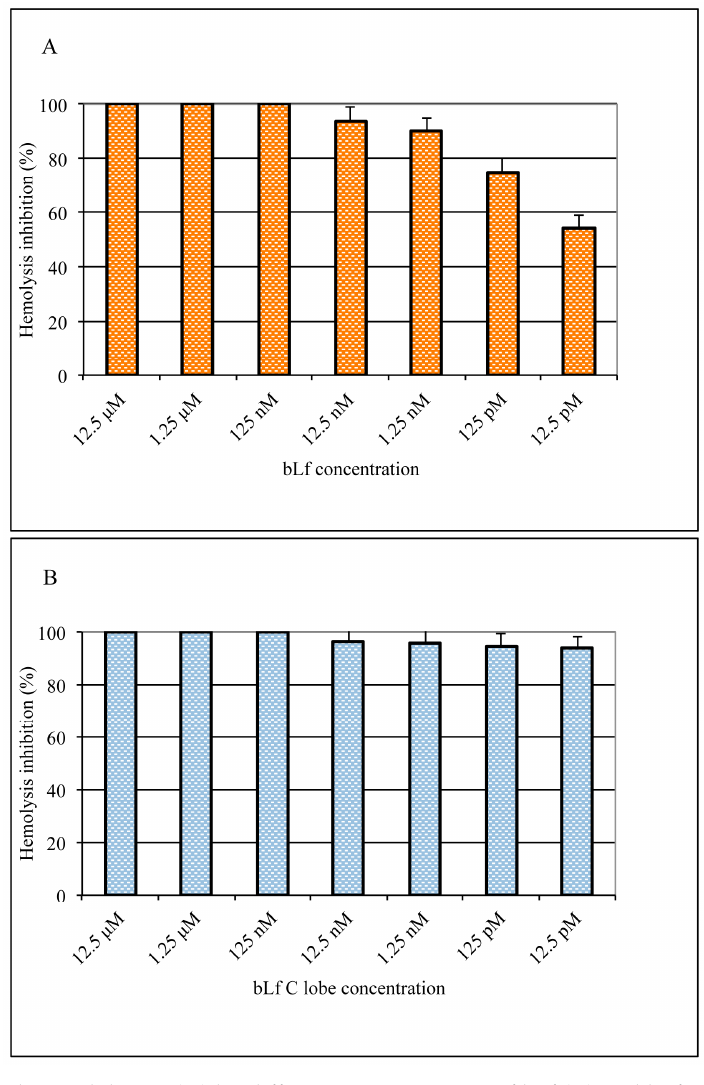
Figure 6. Hemolysis inhibition (%) by different concentrations of bLf ( A ) and bLf C-lobe ( B ). Total (100%) hemolysis was defined by the amount of hemoglobin released in the absence of bLf (virus alone, OD 1.335).